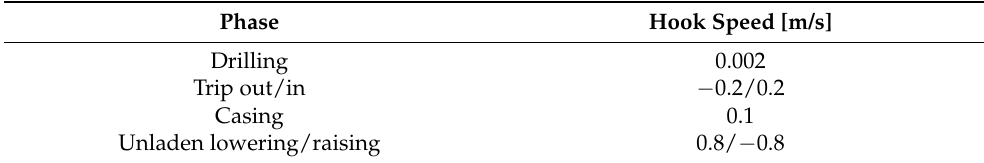
Table 1. Top-drive and hook block speed in each phase.